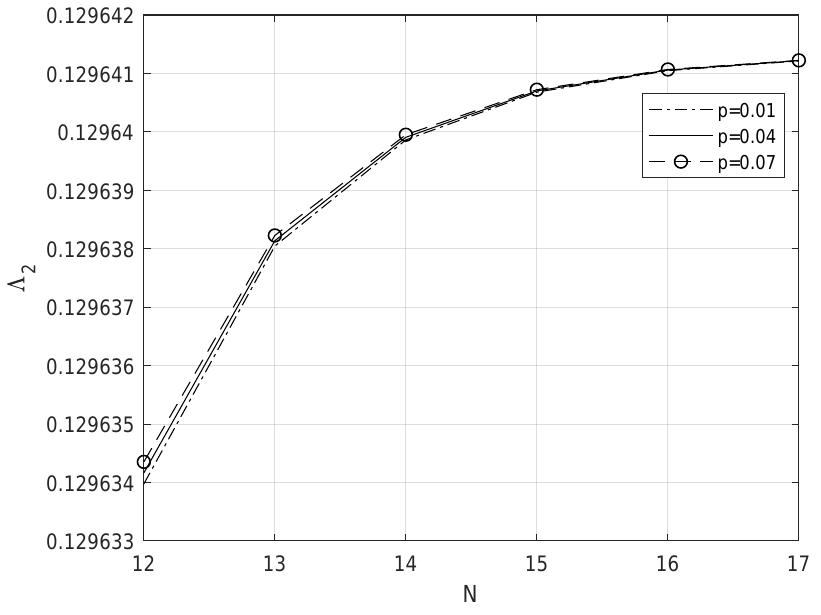
Figure 17. The impact of mean reorder rate when N vs. p